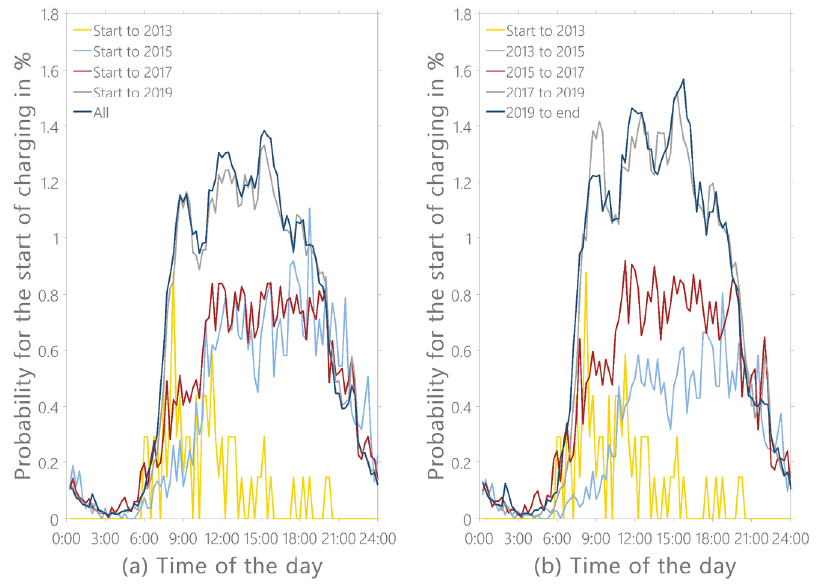
Figure 4. Probabilities for the start of a charging process classified by different recording periods in 15 min resolution: start to the respective year ( a ) and specific time periods ( b ).